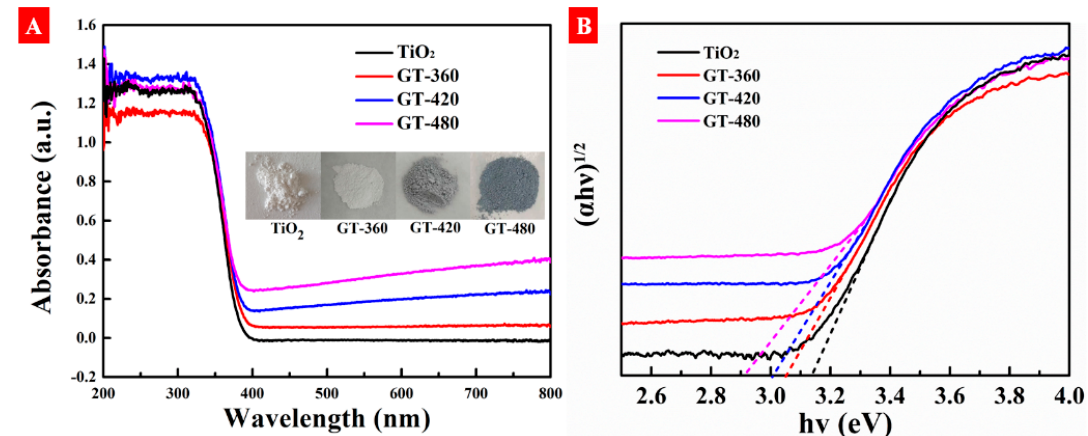
Figure 5. ( A ) UV–Vis diffuse reflectance spectra of as-prepared samples and the digital photos shown 1 / 2 versus h ν using the Kubelka–Munk in the inset. ( B ) The plot of ( α h ν ) 1/2 versus h ν using the Kubelka–Munk function. in the inset. ( B ) The plot of ( α h ν )